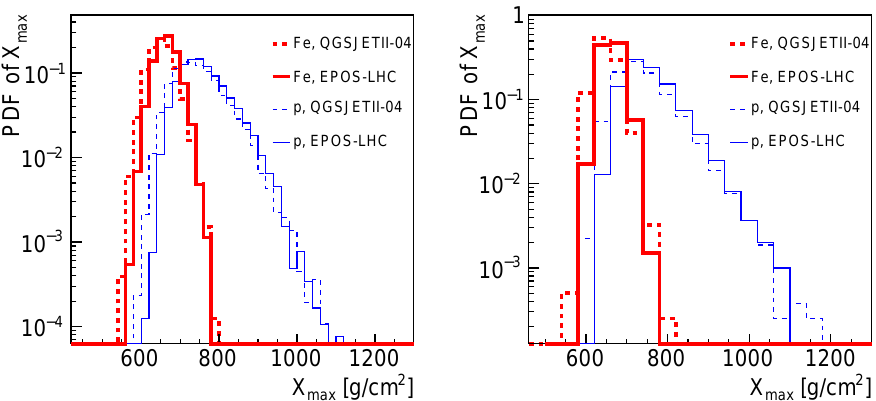
Figure 1. PDFs of X max for proton and iron induced showers as predicted by QGSJETII-04 and EPOS-LHC hadronic interaction models in the energy interval lg E ( eV ) = [18.2–18.3] for Auger ( left ) and TA ( right ) experiments. Note the difference in the bin